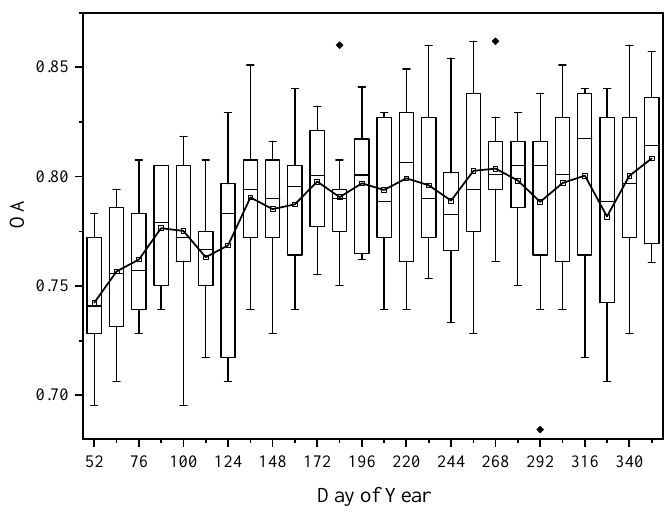
Figure 9. The relationship between classification performance and time series SAR data. The horizontal axis represents the time series data combination from the fourth day to that